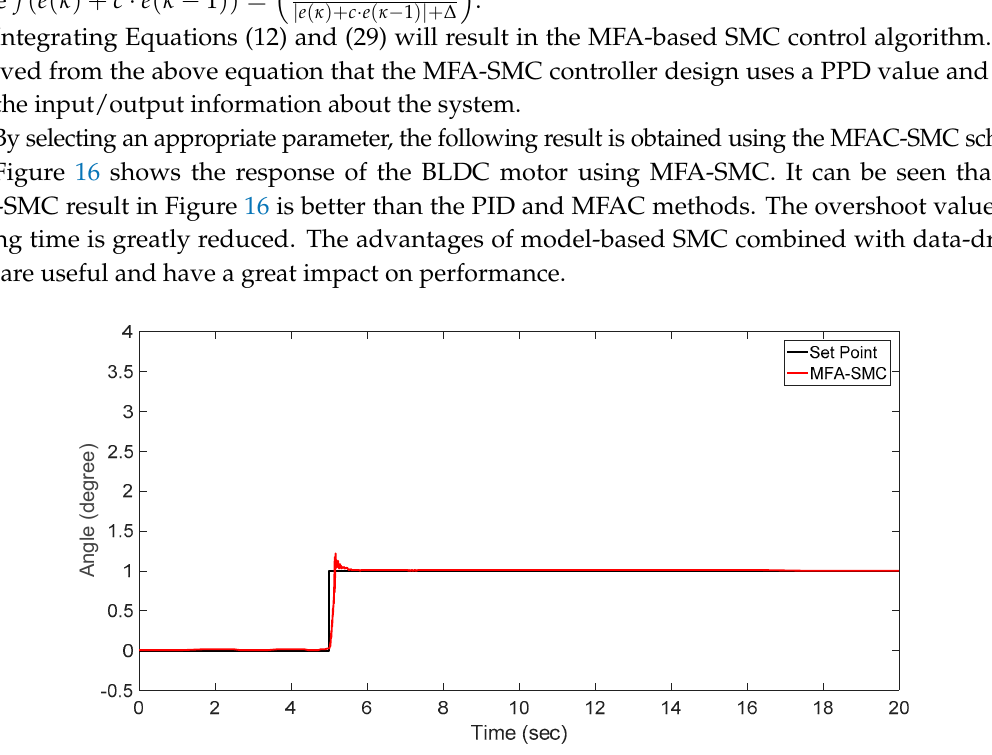
Figure 17. Comparison analysis of step response of the BLDC motor using PID, MFAC, MFLAC, and MFA-SMC. SMC has great significance in the theoretical research fi eld. Nowadays, it is becoming a serious source of solutions to industrial problems. Its potential is proscribed simply by the artistic ability of the individuals working in process control. Thus, the expectation for SMC’s application in the processing industries is huge. The primary bene fi ts of SMC are its invariance and quality properties, and that it can deal with bounded modelling uncertainties and bounded disturbances both in linear and nonlinear systems. Model-Based SMC requires a modelling process, which is expensive and time consuming. To eliminate the modelling process, data-driven SMC is proposed with application to the position